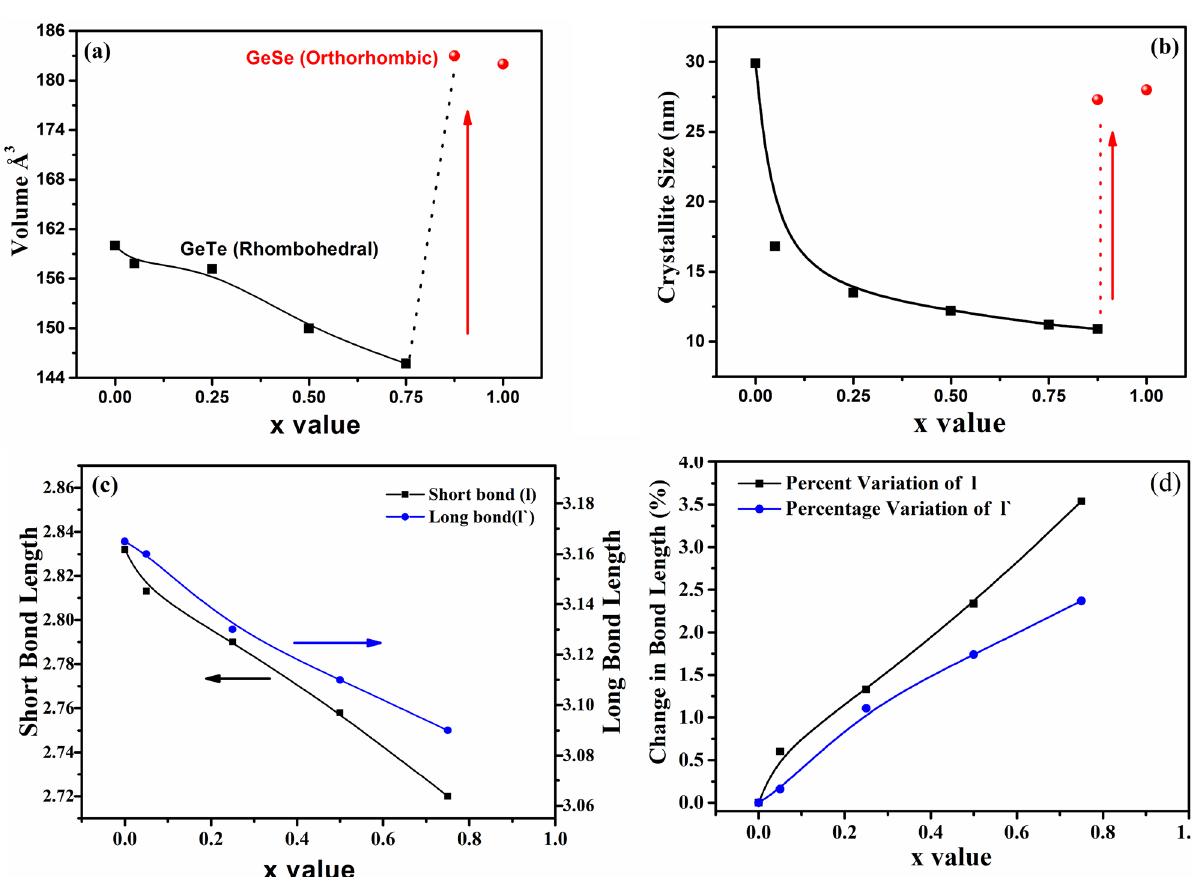
Figure 3. ( a ) Volume and ( b ) crystallite size of the GeTe 1−x Se x bulk samples determined from Rietveld data showing a large change when the layer structured GeSe starts dominating the structure at x ≥ 0.875. The red spheres represent for x = 0.875 and 1.0 where the influence of GeSe on the structure is becoming more pronounced. ( c ) Short and long bond length with Se substitution is showing the decrease of the length of both bonds. ( d ) Change in bond length percentage with Se substitution is found higher in short bonds compared to long